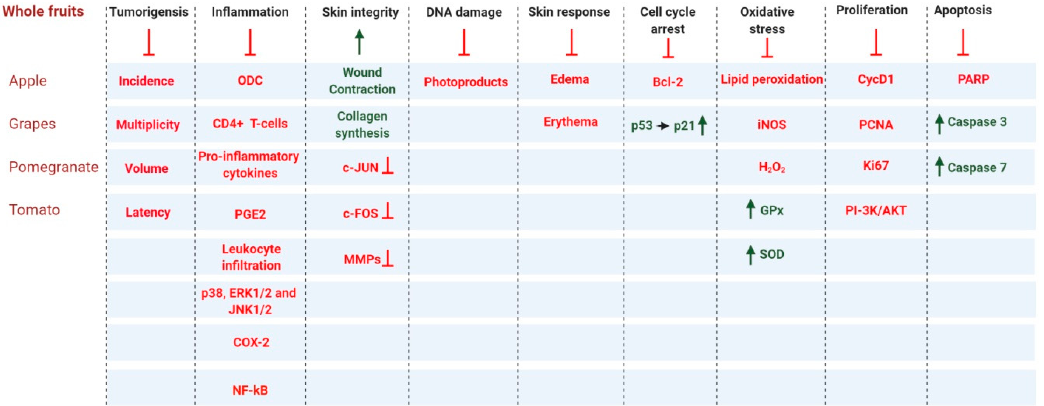
Figure 5. Whole fruit and vegetable products contribute to the prevention of skin carcinogenesis by regulating a broad range of cell signaling pathways. Arrows and dark green text indicate activation and/or upregulation , and red lines with a blunt end and red text indicate inhibition and/or downregulation.